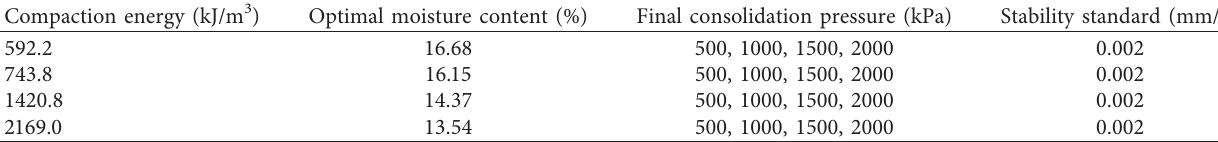
Table 2: Consolidation pressure and stability